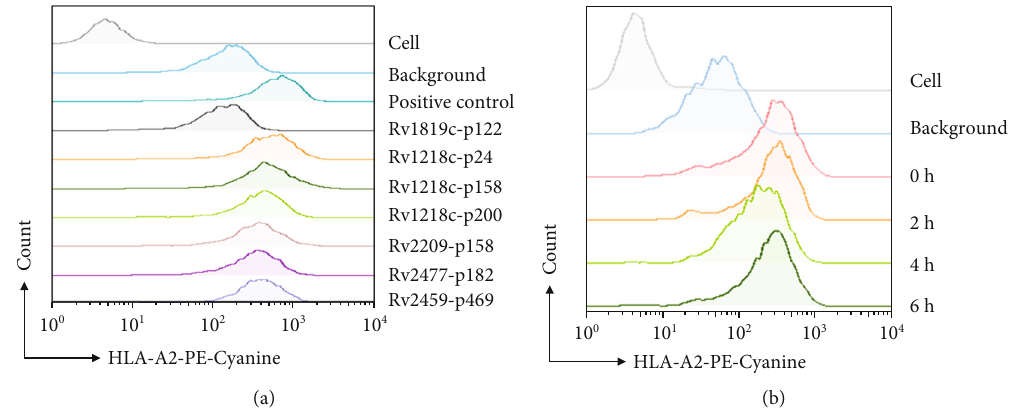
Figure 1: Representative fl ow chart of binding a ffi nity and peptide/HLA-A2 complex stability assay. Representative fl ow chart of (a) the binding a ffi nity of the peptides and (b) peptide/HLA-A2 complex stability assay of peptide